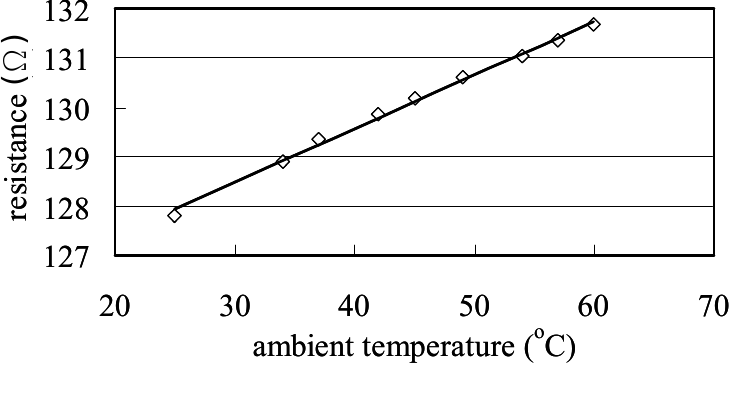
Figure 11. TCR plot of integrated RTD used for temperature compensation purposes (TCR = 0.00078 °C -1